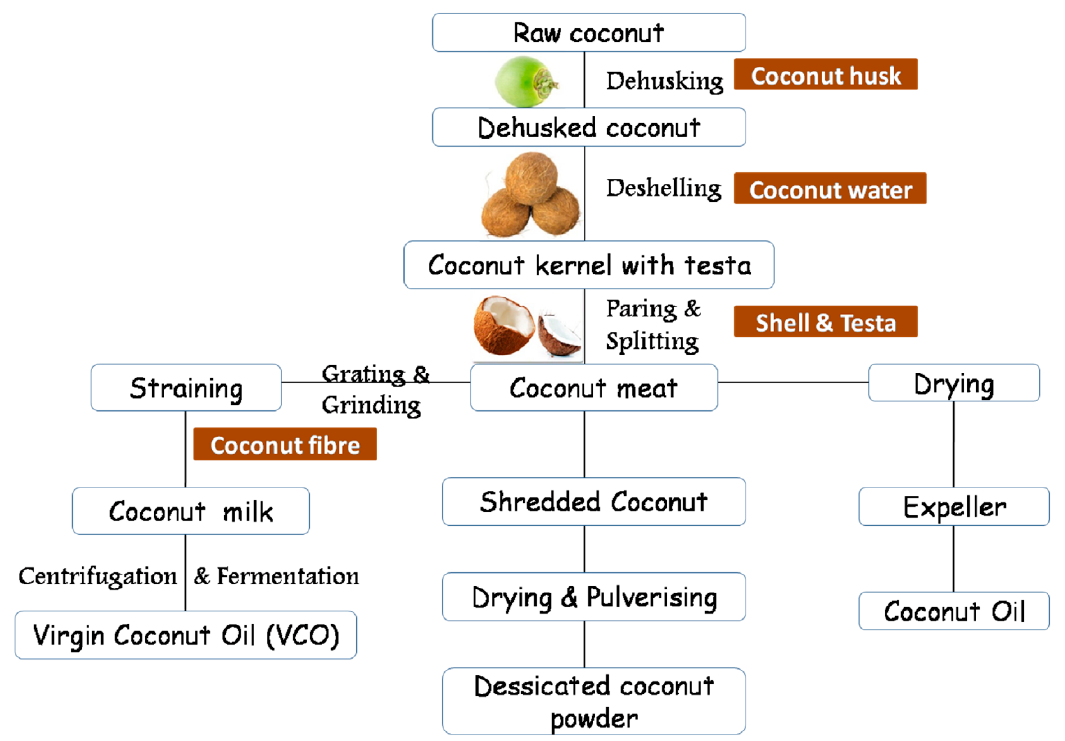
Figure 2. Stepwise procedure for extracting fibers and other products from coconut (adapted from [47]).